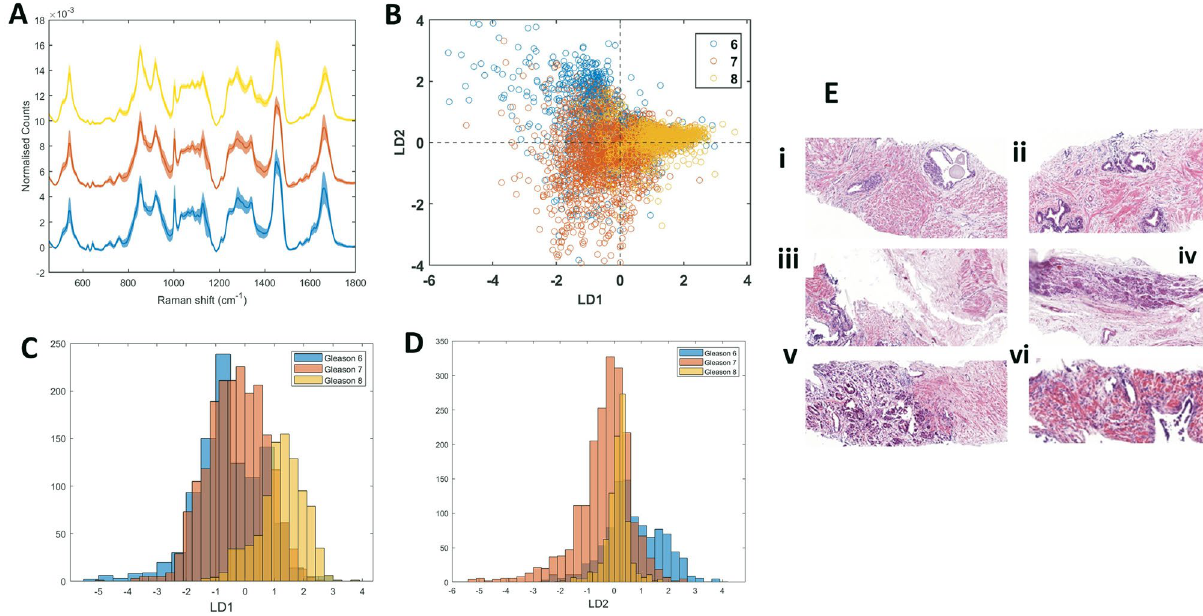
Figure 1. ( A ) Average Raman spectrum of Gleason score 6 tissue (blue), Gleason score 7 tissue (orange) and Gleason score 8 tissue (yellow). Shadow spectrum represents + /− 1 standard deviation. Spectra were acquired using a Renishaw InVia Raman microscope (100 × objective, 785 nm excitation, 30 s acquisition time and 0.45 mW power). Spectra are baseline corrected, normalised and smoothed using a Savitsky-Golay filtering algorithm. ( B ) scatter plot of linear discriminant 1 (LD1) and linear discriminant 2 (LD2) scores obtained from RS-GBR-NMF-sparseLDA classification of RS acquired from Gleason score 6 (blue points), 7 (orange points) and 8 (yellow points). ( C ) Histogram of LD1 scores obtained from RS-GBR-NMF-sparseLDA classification of RS acquired from Gleason score 6 (blue points), 7 (orange points) and 8 (yellow points). ( D ) Histogram of LD2 scores obtained from RS-GBR-NMF-sparseLDA classification of RS acquired from Gleason score 6 (blue points), 7 (orange points) and 8 (yellow points). ( E ) Pre-treatment (LEFT) and post-treatment (RIGHT) (single dose) haematoxylin and eosin (H&E) stained images of patients 76 (i,ii), 86 (iii,iv) and 88a